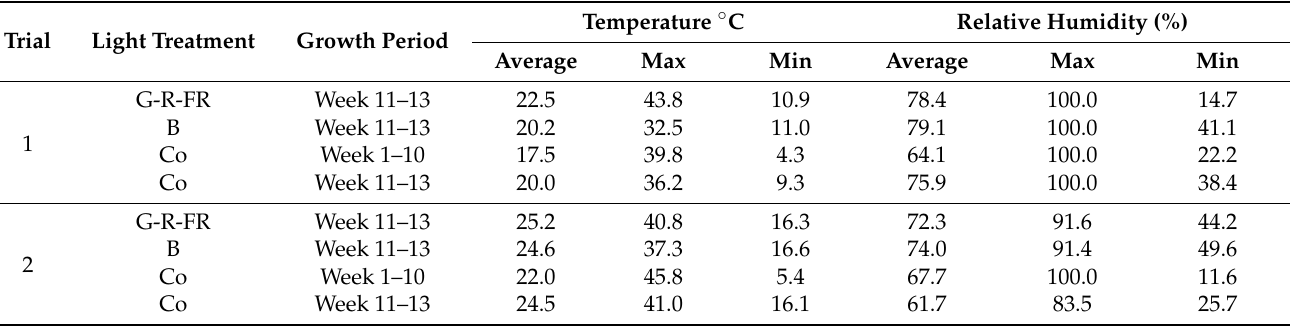
Table 5. Average temperature and relative humidity during light treatments. Co (control), B (blue), G-R-FR